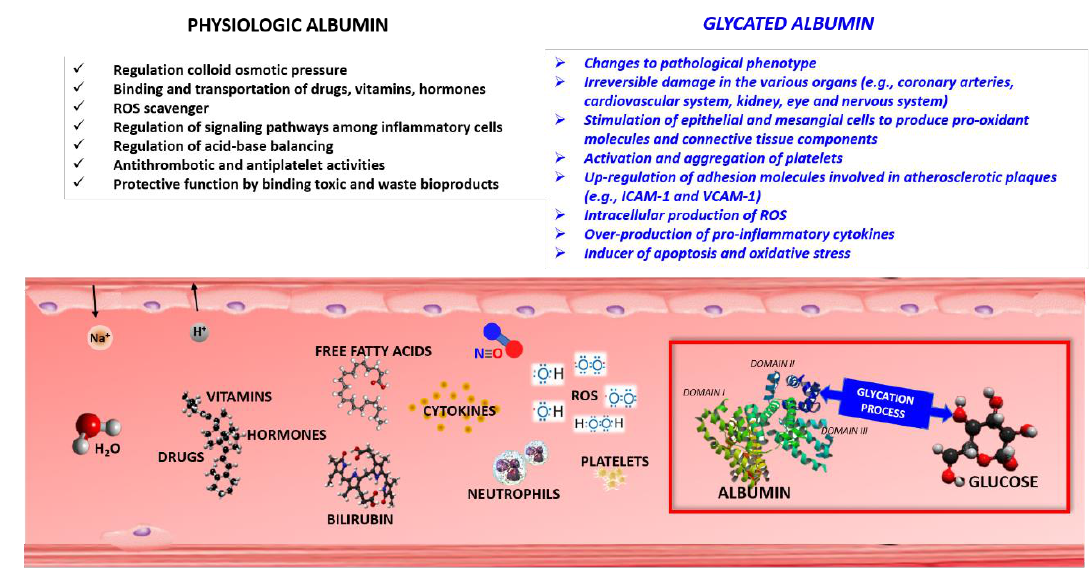
Figure 1. Schematic representation of the main physiological functions of albumin and pathological actions after specific glycation processes; ROS: reactive oxygen species; N = O: nitric oxide; ICAM-1: intercellular adhesion molecule-1; VCAM-1: vascular cell adhesion molecule-1. GA Test